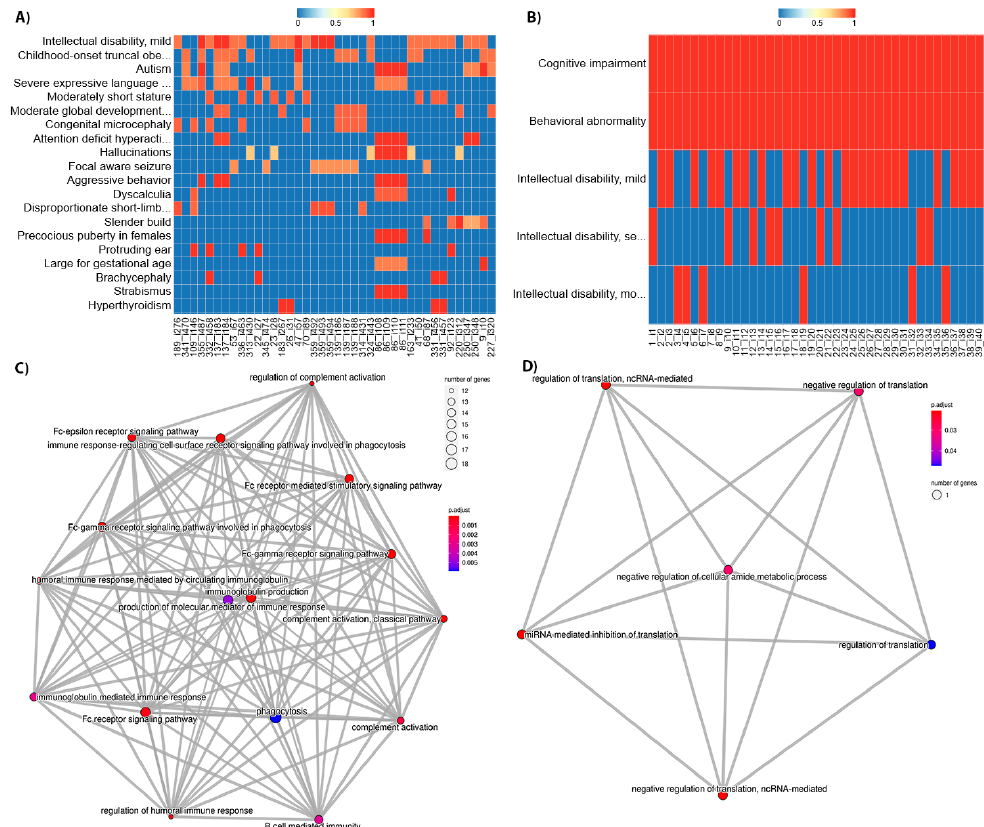
Figure 8. Columns represents DECIPHER and ID/MCA cohorts top semantic similarity cluster examples, respectively. ( A , B ) show heatmaps with the semantic similarity between the patients from the cluster and the phenotypic spectra of the cluster itself. The patient axis (x) is sorted according to decreasing semantic similarity with the phenotypic spectra. The HPO axis (y) shows the phenotypic spectra for the cluster, sorted by average semantic similarity with the patient profiles. The top 20 HPO terms and 40 patients are illustrated. ( C , D ) show functional enrichment for the genes mapping to the variants shared by patients in the clusters, performed using Gene Ontology, Biological Process terms. Nodes represent GO terms, sized according to the number of patient genes annotated with the given term. The numbers of shared genes between GOs are represented by grey links. The patient identifiers shown in the heatmaps are randomly generated and bear no relation to the original cohort